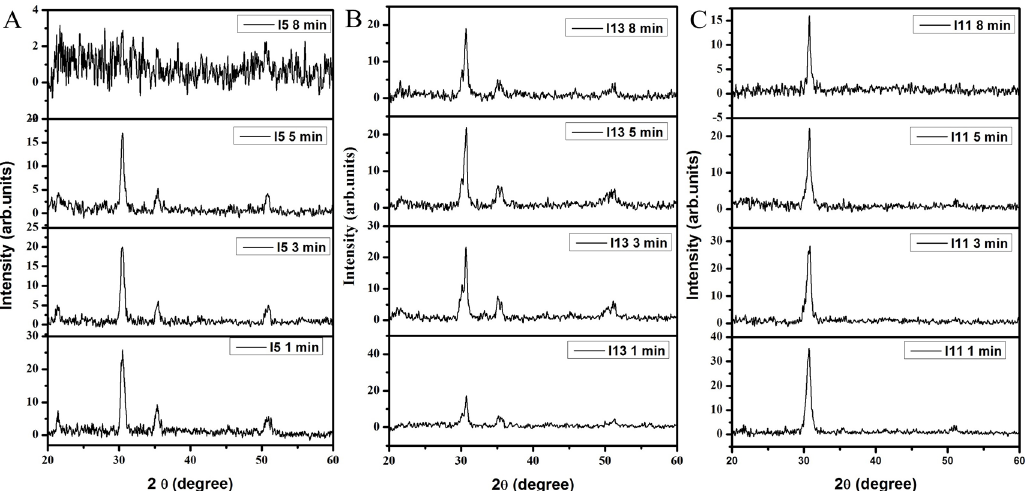
Figure 1. XRD pattern for ITO films deposited under different oxygen ambient conditions and etched for 1, 3, 5 and 8 min: ( A ) 0 sccm oxygen; ( B ) 0.4 sccm oxygen; ( C ) 1.0 sccm oxygen. Argon flow rate was maintained at 10 sccm for all materials.